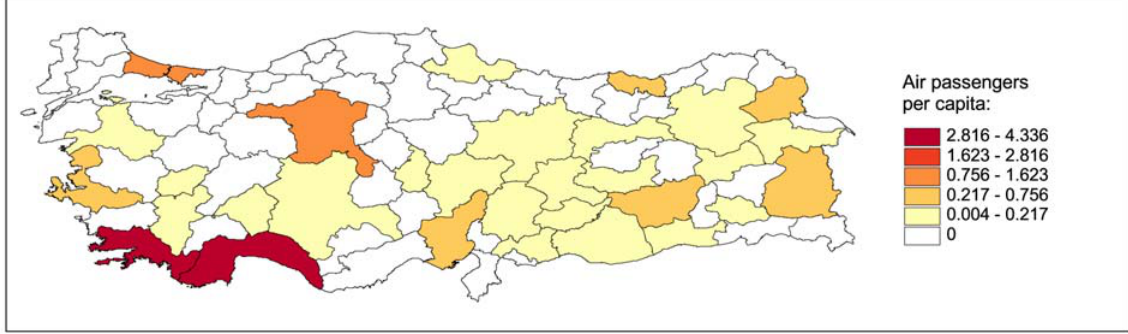
Figure 2. The distribution of per capita air passenger traffic among Turkish provinces for 2000 The major hypothesis of this study is that air passenger traffic can stimulate local employment in most industries and occupations; and accordingly, we suppose air passenger traffic per capita should get a positive coefficient. In regards to population, we think that population of a province can change the composition of the local employment, as some rural and low-population provinces may heavily rely on agricultural activities whereas bigger cities can easily attract bigger businesses and accordingly more white-collar workers. So, the independent variable population should get both positive and negative coefficients, depending on the employment variable used in the regression estimation. As the percentage of the population able to work will directly affect the employment, we anticipate that labourforce should get a positive coefficient. On the other hand, we believe that income levels of the provinces tend to shape their employment mixes and developed provinces are generally more successful in attracting high value-added industries and occupations necessitating qualified human resources; and as a result, we expect that being a high-income province should increase employment in such industries and occupations. The independent variable per capita GDP should therefore get a positive coefficient for such industries and